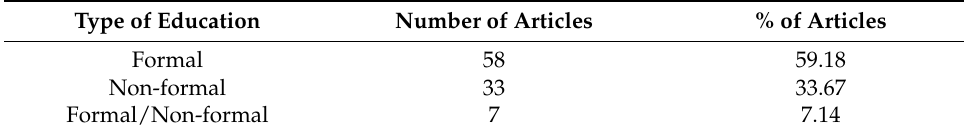
Figure 4. Number of articles included in the systematic review per year. Table 5. Percentage number of articles according to type of